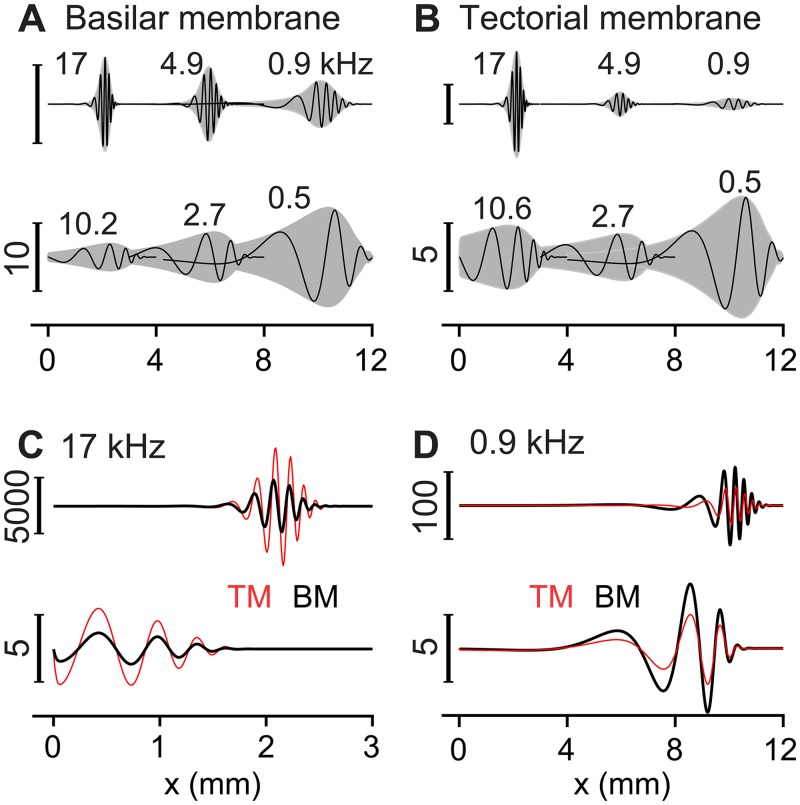
Traveling waves.(A) BM vibration patterns at three different stimulation frequencies when active (top) or passive (bottom). The shaded areas are the envelope of the traveling waves. Labels are the best frequencies at x = 2, 6 and 10 mm. (B) TM vibration patterns. (C) Comparison of the BM and the TM vibration patterns when stimulated at 17 kHz. (D) Comparison of the BM and the TM vibration patterns when stimulated at 0.9 kHz. For each panel, the top and bottom plots represent the active and passive response. The numbers next to the scale bar indicate the amplification factor (re. oval window displacement). The scale bars in the top plots of panel A and B correspond to 4000/4000/20 for the base/middle/apex curves, respectively.